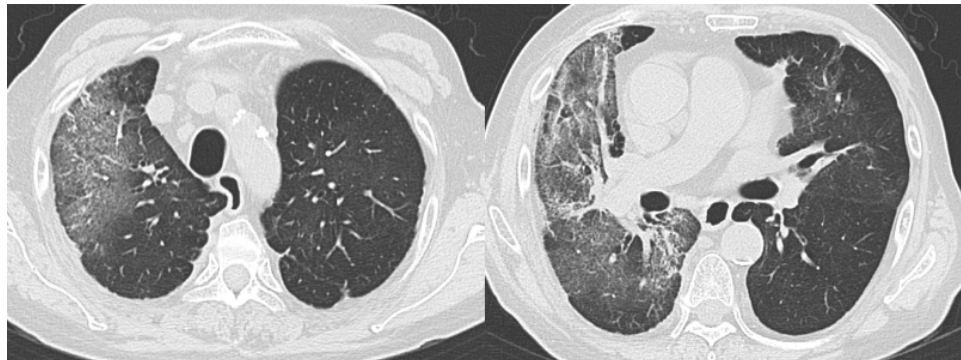
Figure 5. Representative CT images of a COVID-19-negative patient. Thirty-four-year-old female. The CT images show segmental consolidation with mucus plug (arrow). RT-PCR was negative for SARS- CoV-2 and she was diagnosed with community-acquired pneumonia. All readers diagnosed it as Category 2. COVID-19, coronavirus disease 2019; CT, computed tomography; RT-PCR, reverse transcription-polymerase chain reaction; SARS-CoV-2, severe acute respiratory syndrome coronavirus 2.